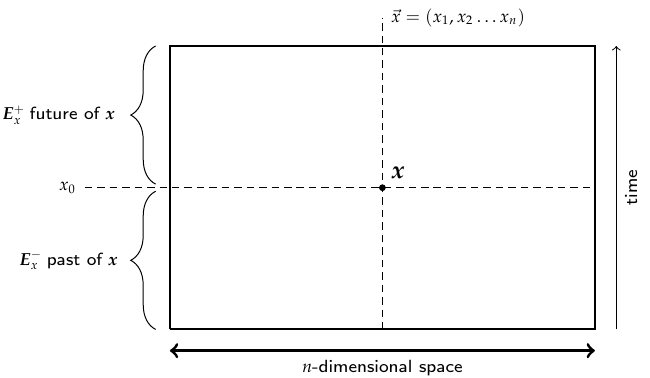
Figure 2. A limited portion of the space–time centered about the event x = ( x 0 , x 1 , x 2 . . . x n )